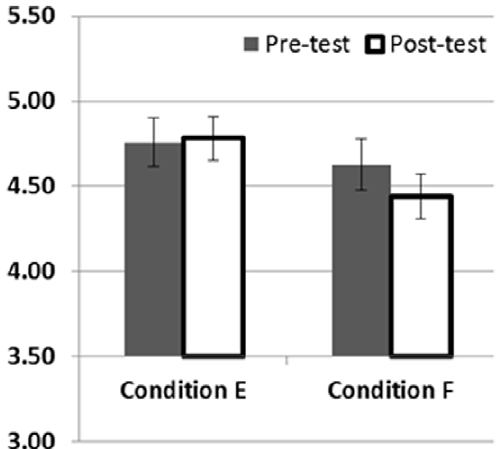
Figure 3. Mean ‘preference for thinness’ at pre- and post-test, for each condition in Study 2. Those in Condition E were shown a combination of thin aspirational bodies and large non-aspirational bodies during the manipulation phase, while those in Condition F were shown large aspirational bodies and thin non-aspirational bodies.